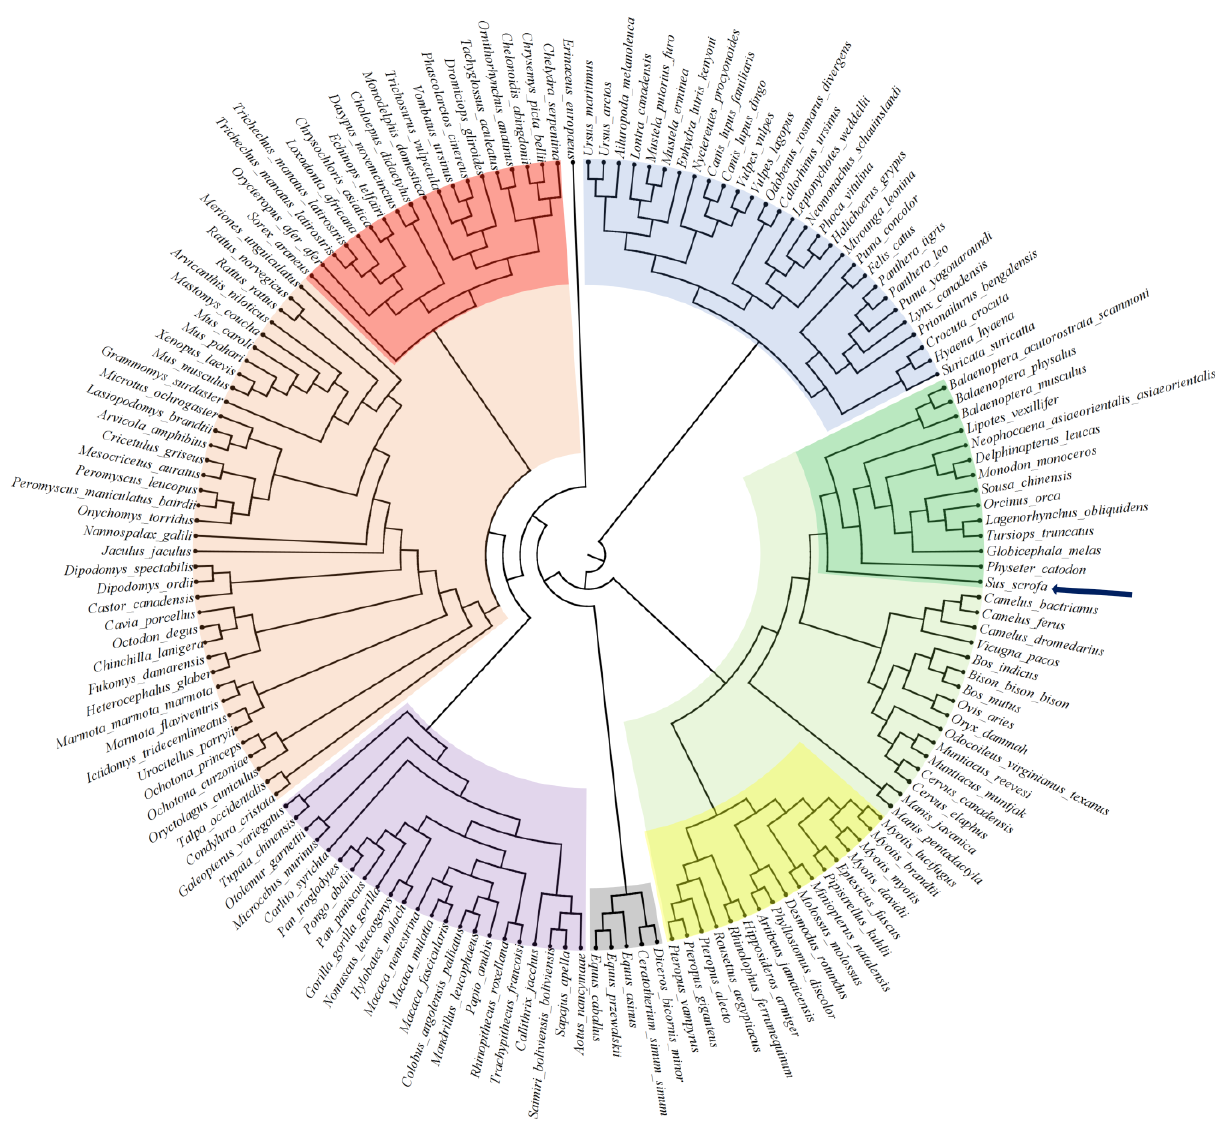
Figure 2. Phylogenetic analysis of 3-hydroxy-3-methylglutaryl coenzyme A (HMG-CoA) reductase (HMGCR) originated from amino acid differences in animal protein sequences. The circular tree was created by downloading amino acid sequences from NCBI using BLASTp search, while the distance of each entry was calculated using CLC software. In the figure, a division can be observed between carnivores (blue), whales and dolphins (dark green), even-numbered ungulates (light green), bats (yellow), odd-numbered ungulates (gray), primates (purple), rodents (orange) and marsupials, planktonic and oviparous (red).